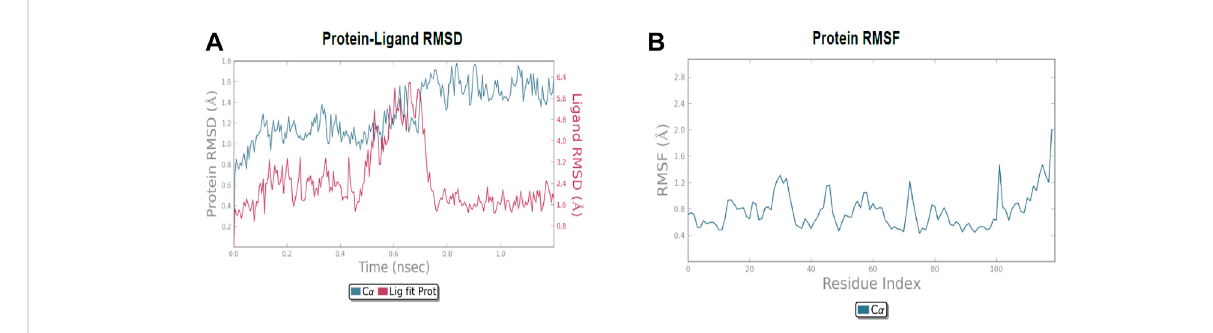
FIGURE 13 (A) RMSD of protein-ligand ( 6c 3W2S) throughout 2ns and (B) RMSF of